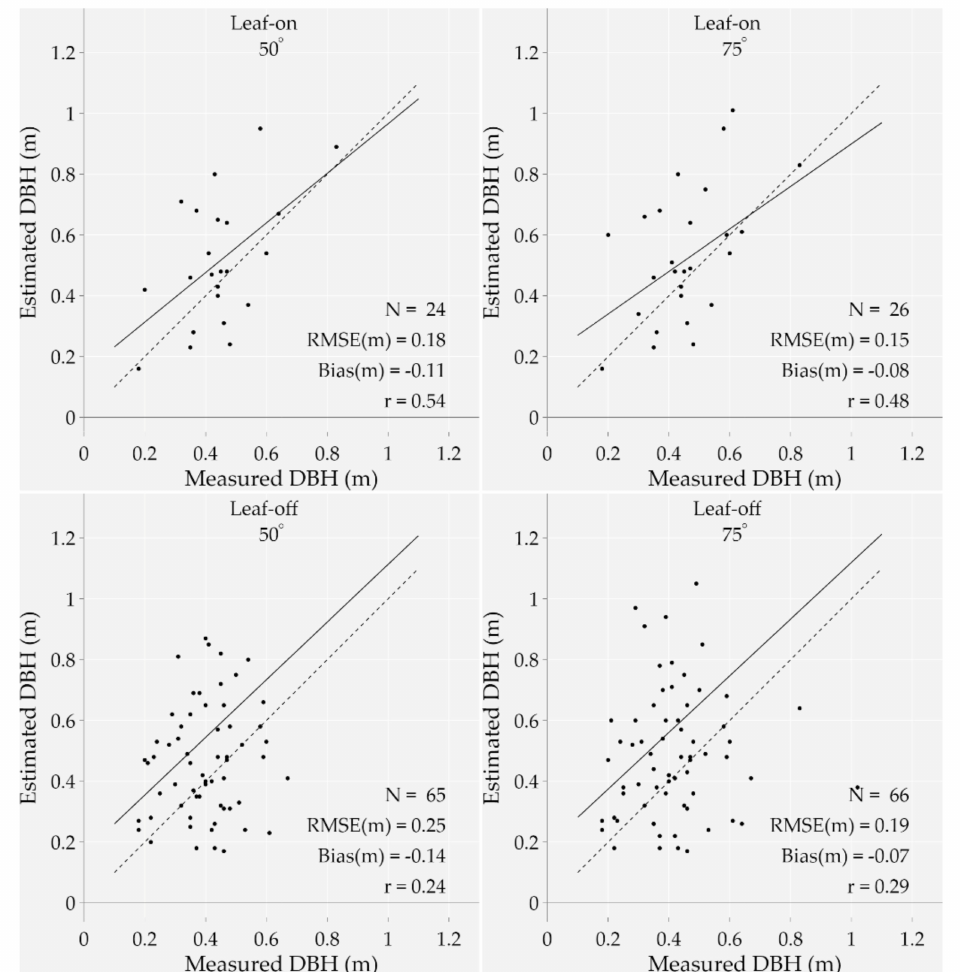
Figure 8. Measured versus estimated diameters at breast height from four point-clouds acquired at two different seasons (leaf-on ad leaf-off) and using two MSARs (50 ◦ and 75 ◦ ). The bias, RMSE, and correlation coefficient (r) are shown on the plots as well as the 1:1 line (dotted line) and the regression line (solid line). Additionally, the number of data points (N) is different for each plot. Note that outliers were removed from the